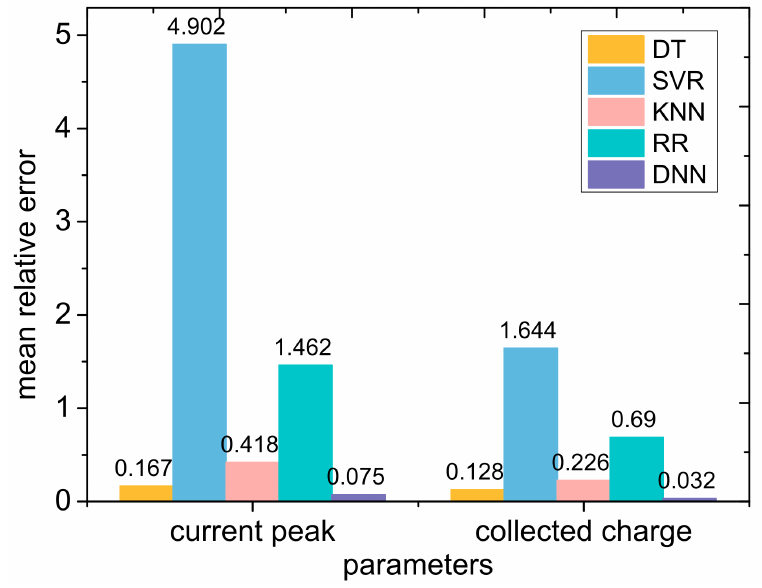
Figure 10. Comparison of the mean relative errors for the peak drain transient current and total collected charge as predicted by traditional machine learning and deep neural network